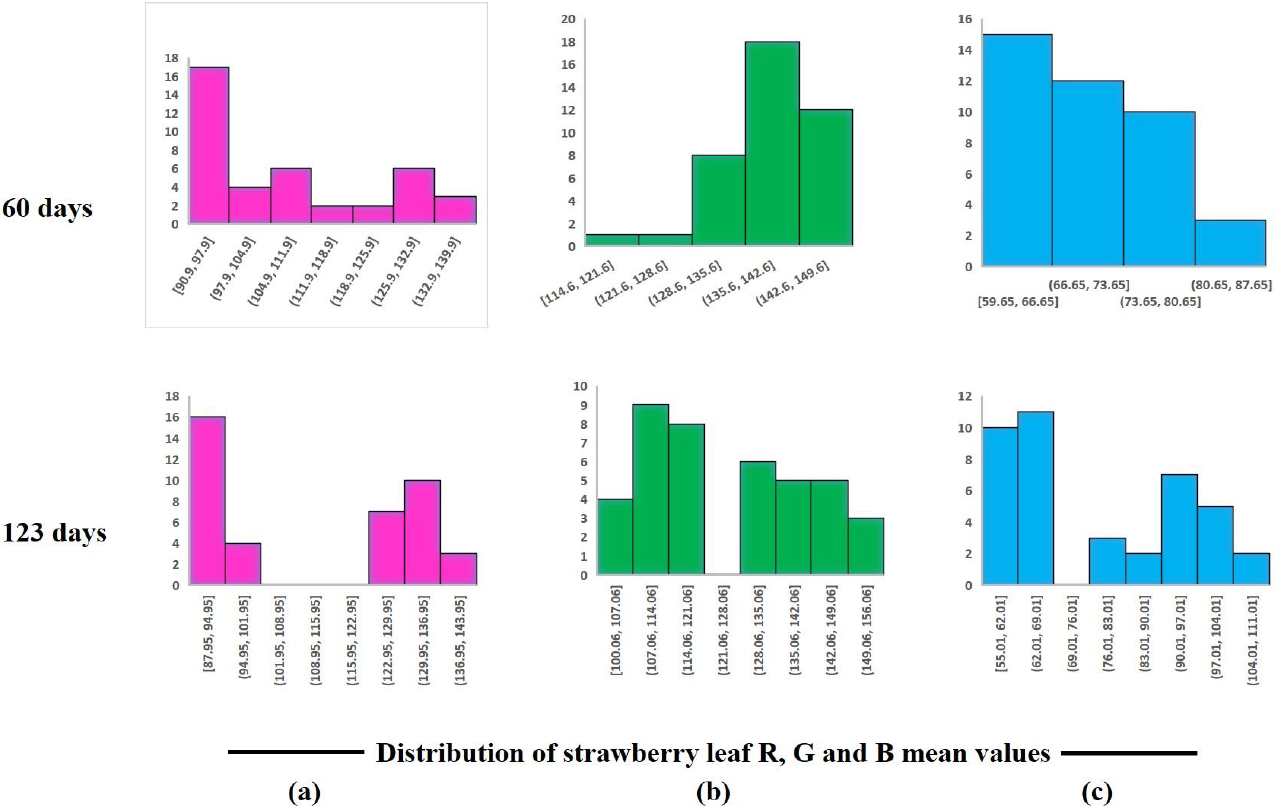
Figure 5. Histograms of strawberry leaf color distribution are shown at 60 and 123 days of leaf age: ( a ) distribution of R means values, ( b ) distribution of G means values, and ( c ) distribution of B means values.